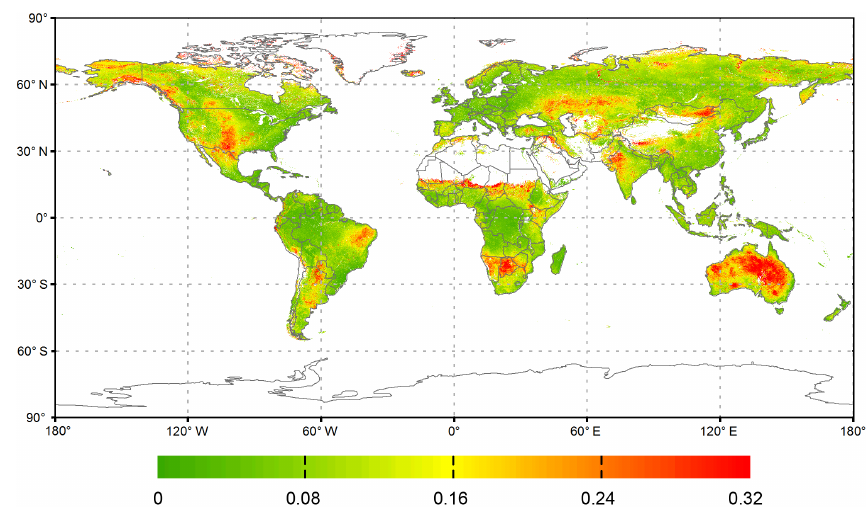
Figure 1. The interannual variability (i.e., the coefficient of variation or CV) of annual gross primary productivity (GPP) over the period 2000–2014 from the MODIS GPP product (MOD17A3). The CV is